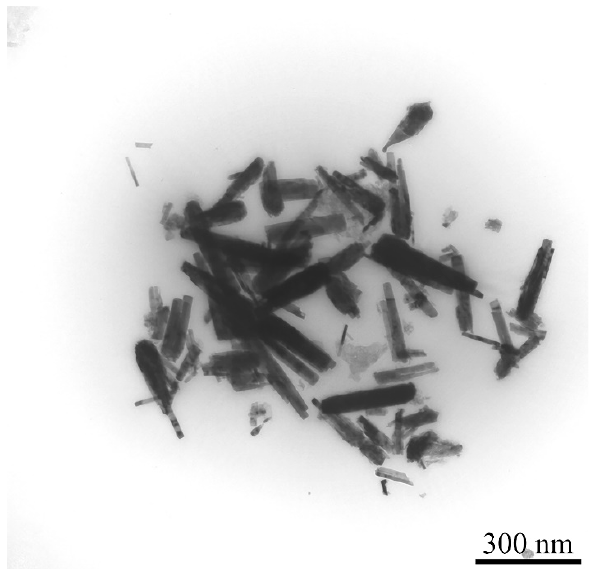
Figure 3 . Transmission electron microscopy (TEM) photograph of the prepared ZnO nanorods.